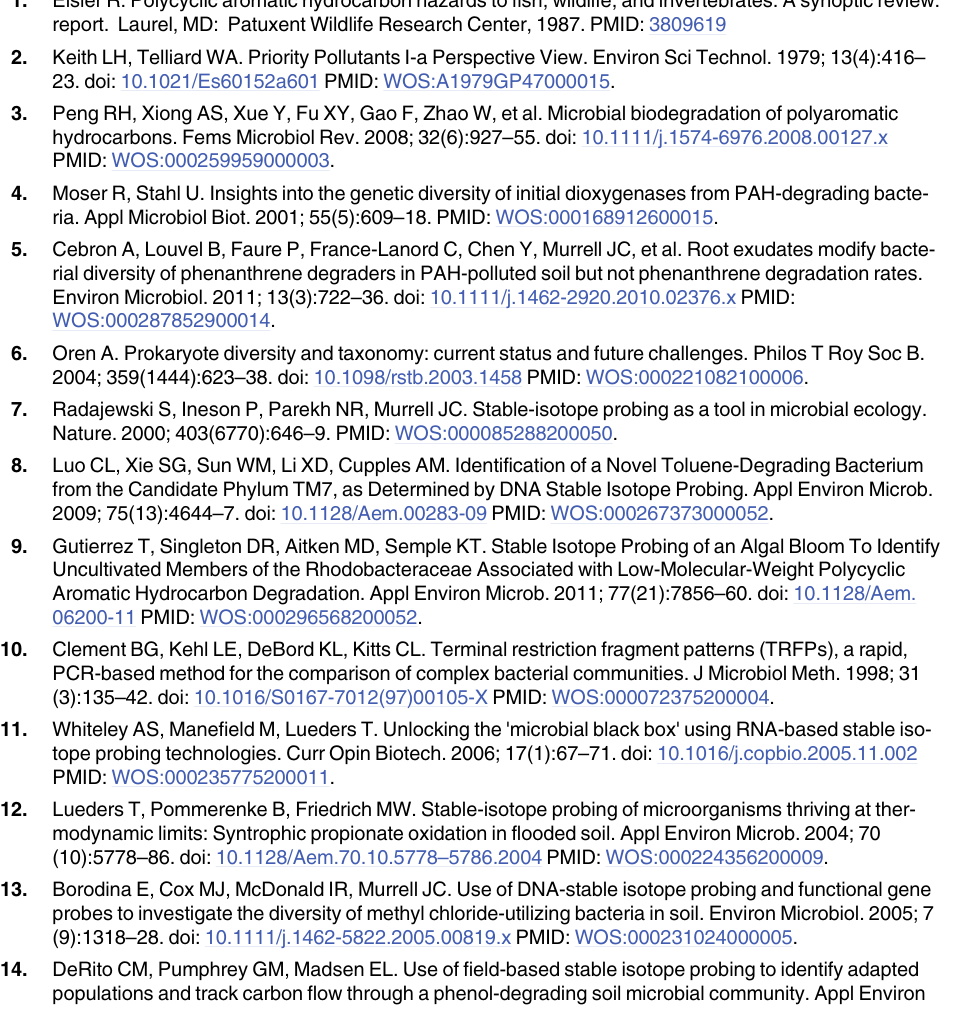
S7 Table. Numerical data to S2